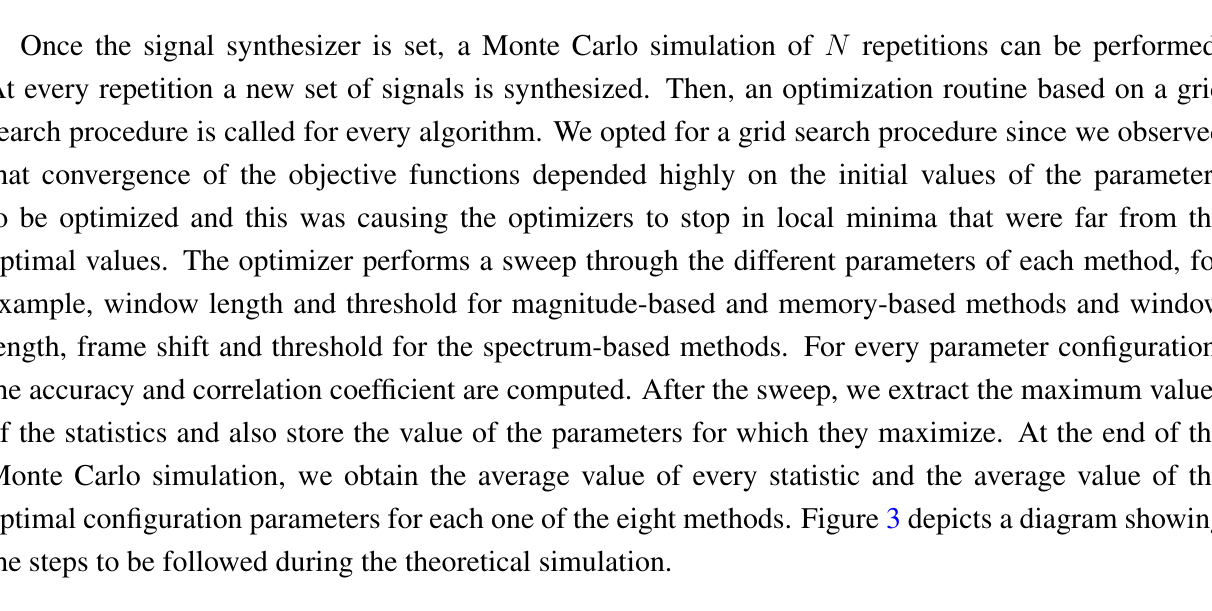
Figure 3. Theoretical simulation diagram. A Monte Carlo simulation is performed to ensure statistical